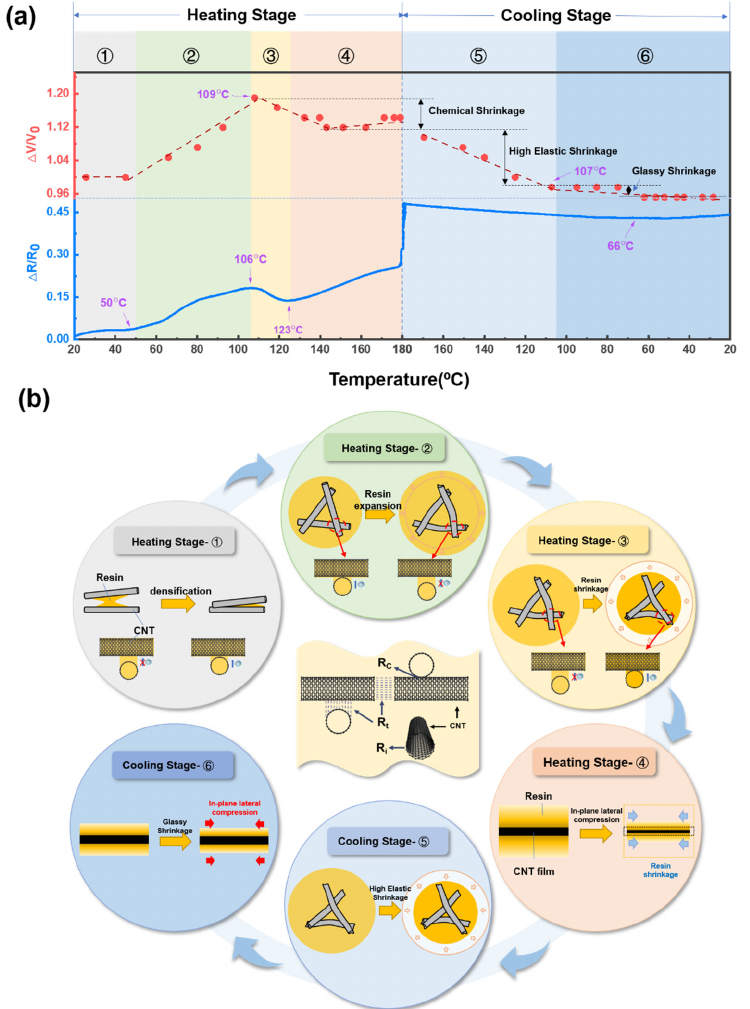
Figure 3. ( a ) The variation in electrical resistance of CNT/E51-DAD-90 and the relative volume change with temperature for E51-DAD resin system, and ( b ) illustrations of the electrical resistance evolution of CNT/epoxy composite film during curing process.